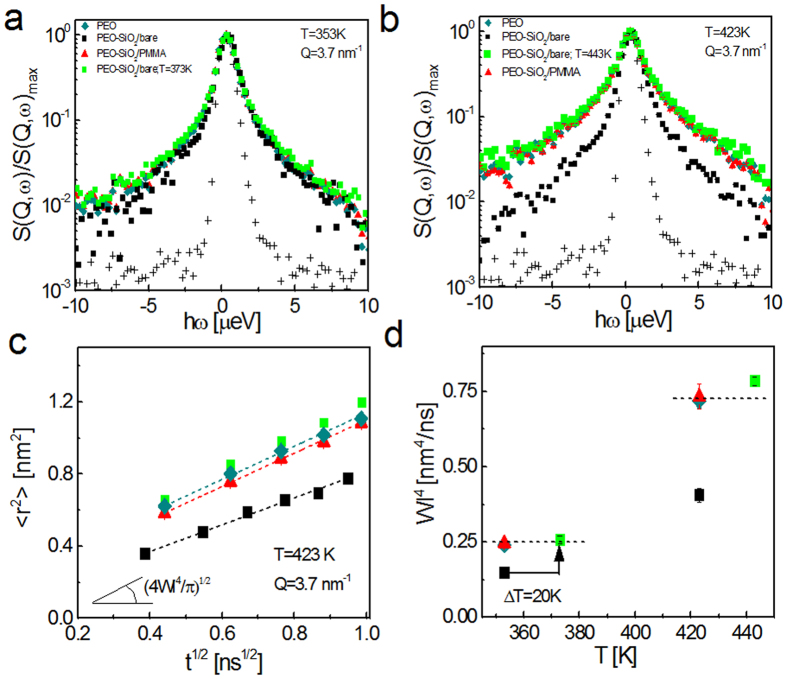
Incoherent dynamic structure factor and mean square displacement of PEO.Dynamic structure factor of PEO and nanocomposites in the frequency domain obtained in backscattering at (a) low and (b) high temperature. Symbols (+) represent the resolution data for neat PEO taken at ≈10 K. (c) Mean-square displacement (MSD) obtained from the inverse-Fourier transformed backscattering data at Q = 3.64 1/nm plotted on Rouse scaling (). (d) Rouse Parameters (Wl4) of PEO in particle-free form and nanocomposites reveal unchanged monomeric relaxation in weakly interacting PMMA interfaces and slowing down in the bare system, which requires 20 K higher temperature to reach similar Rouse rates (green squares).